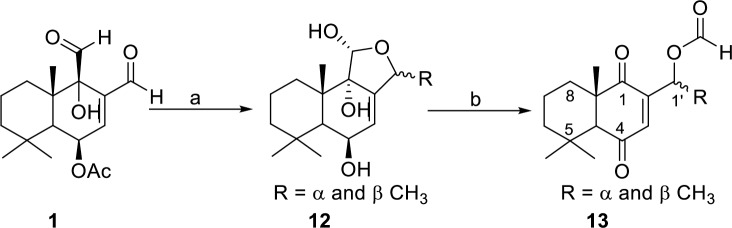
Synthesis of 1,4-dione 13.Reagents and conditions: (a) 5 equiv MeMgBr, THF, −78°C, 2 h; (b) 3.3 equiv PCC, DCM, 0 oC → r.t., 2 h.